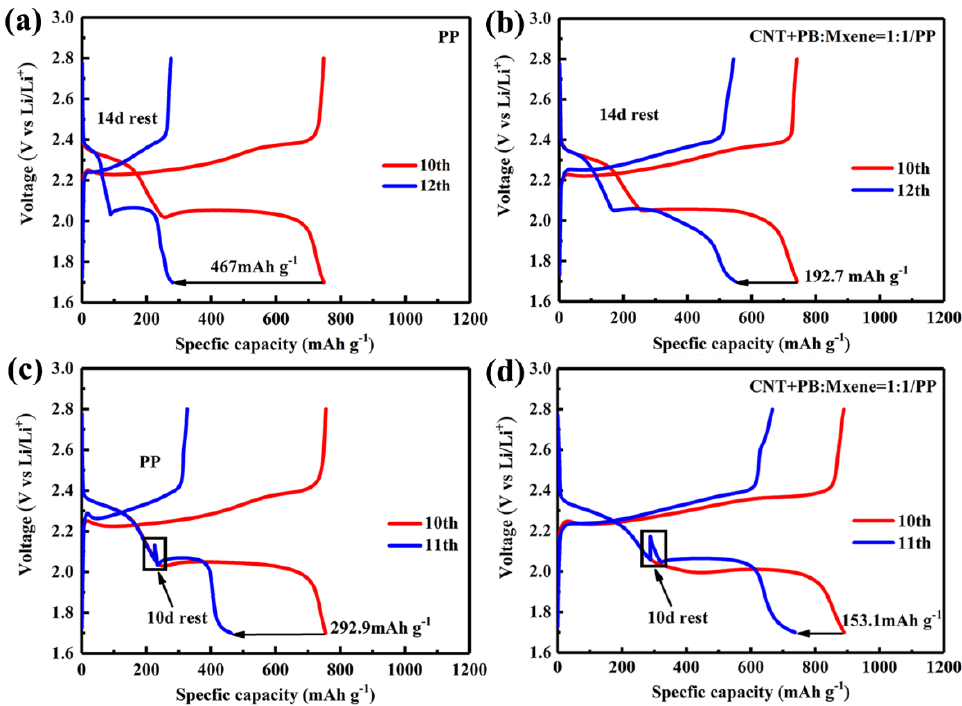
Figure 6. Self-discharging curves of LSBs with different separators of PP ( a , c ) and CNT+PB@MXene ( b , d ) after 14- and 10-day rest at 2.8 and 2.06 V, respectively.